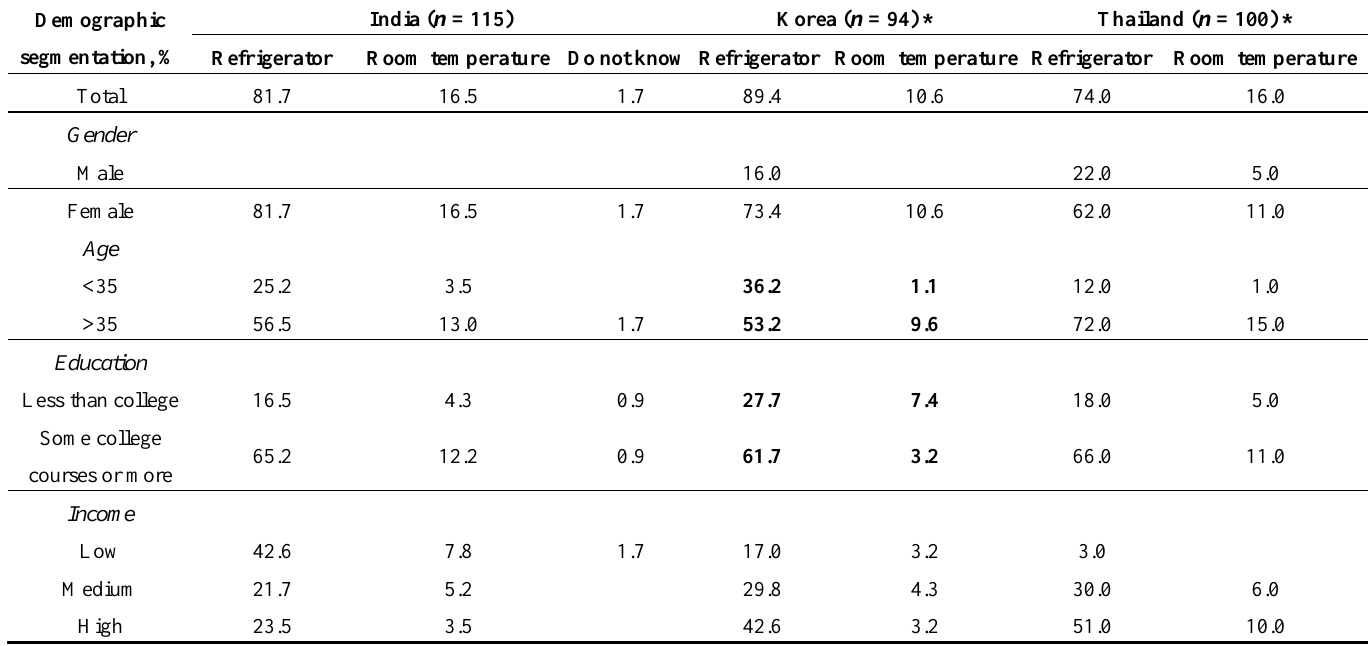
Table 4. Consumers’ storage behavior of raw eggs in the shell. Where would you store the food